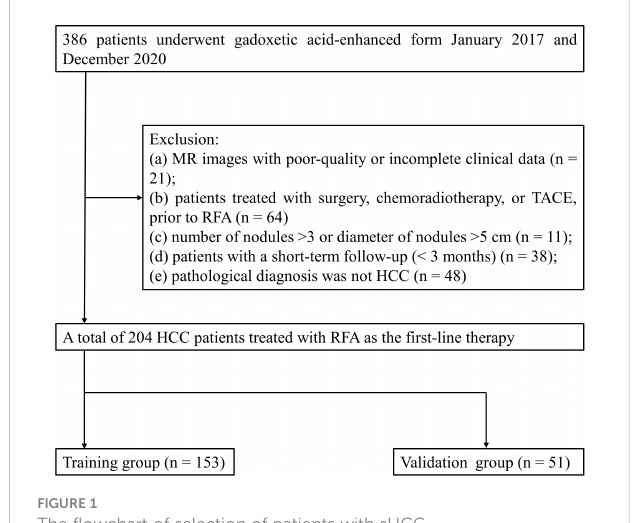
FIGURE 1 The fl owchart of selection of patients with